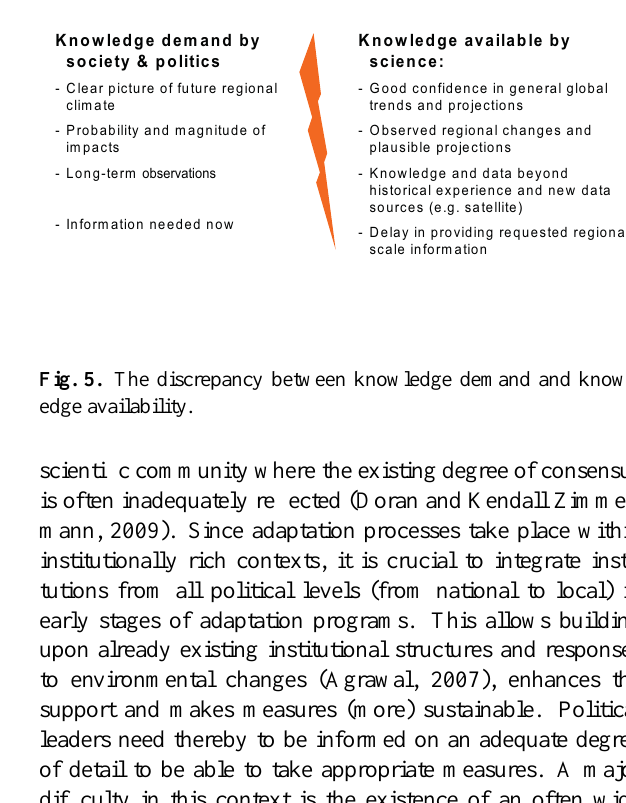
Fig. 4. As an example of climate projections, mean specific hu- midities are shown for June 1980–1999 based on NCEP Reanaly- sis (A) , and for 2046–2065 for SRES-scenario A1B as modelled in the Global Circulation Models for the central part of South Amer- ica: Bjerknes Center BCM2 (B) , Canadian Center CGHR (C) , Hadley Center CM3 (D) and Meteorological Institute of Japan MRI- MRCGCM (E) . These IPCC-AR4 based results do not provide suf- ficient detail and clarity as to whether the dry austral winters in the regions of Cusco and Apur´ımac (geographic limits indicated) will even be drier in future than at present (data courtesy IPCC).